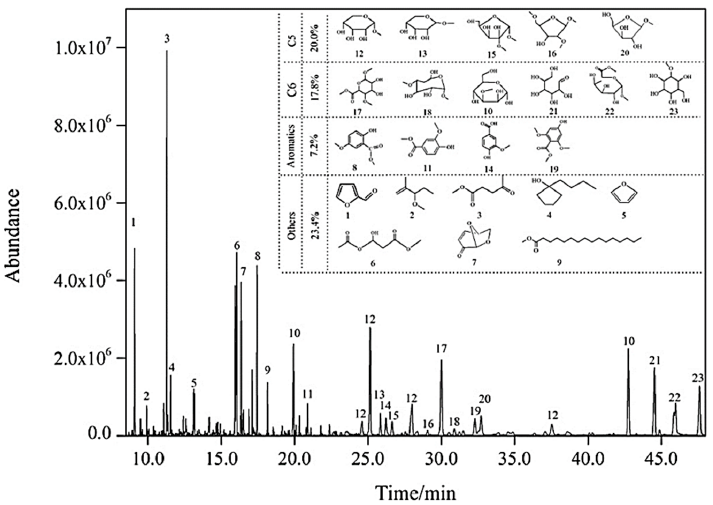
Figure 14. GC–MS chromatogram of bio-polyol via microwave liquefaction [99] .